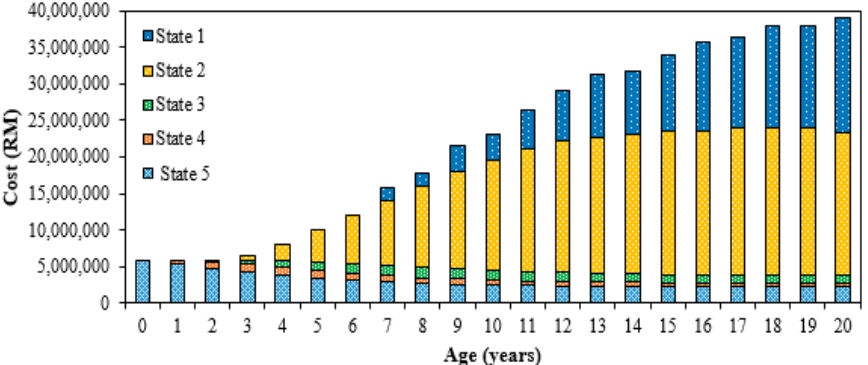
Figure 10. Maintenance cost for transformers in each state for transition states for the year 2013/2014.